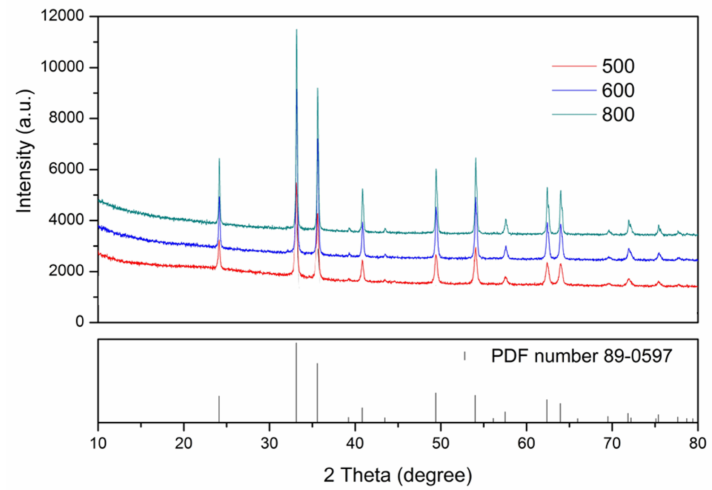
Figure 3. X-ray diffractograms of samples calcined at 500 ◦ C, 600 ◦ C, and 800 ◦